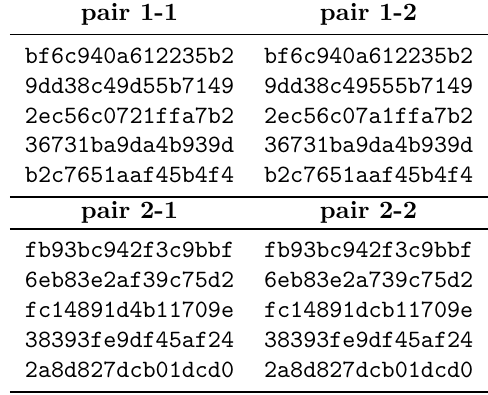
Table 20: Conforming pairs for 4 rounds of rectangle